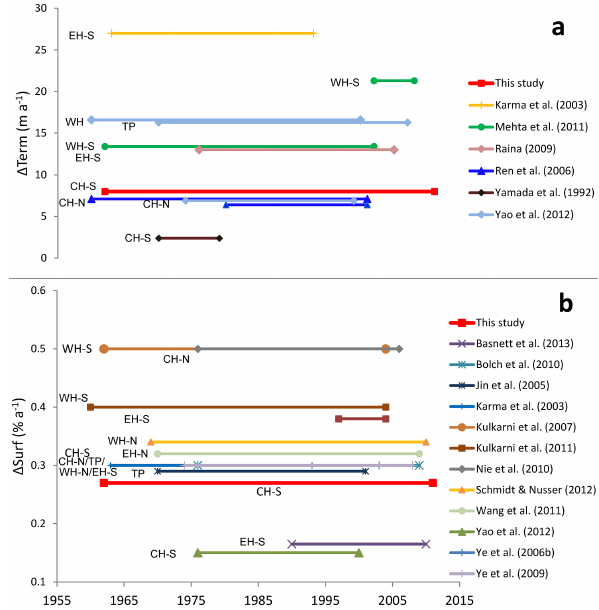
Figure 5. Recent studies on the variations of Himalayan glaciers concerning both the terminus retreat (a) and the surface area loss (b) . Data and references of this figure are presented Table S4 of the Supplement.